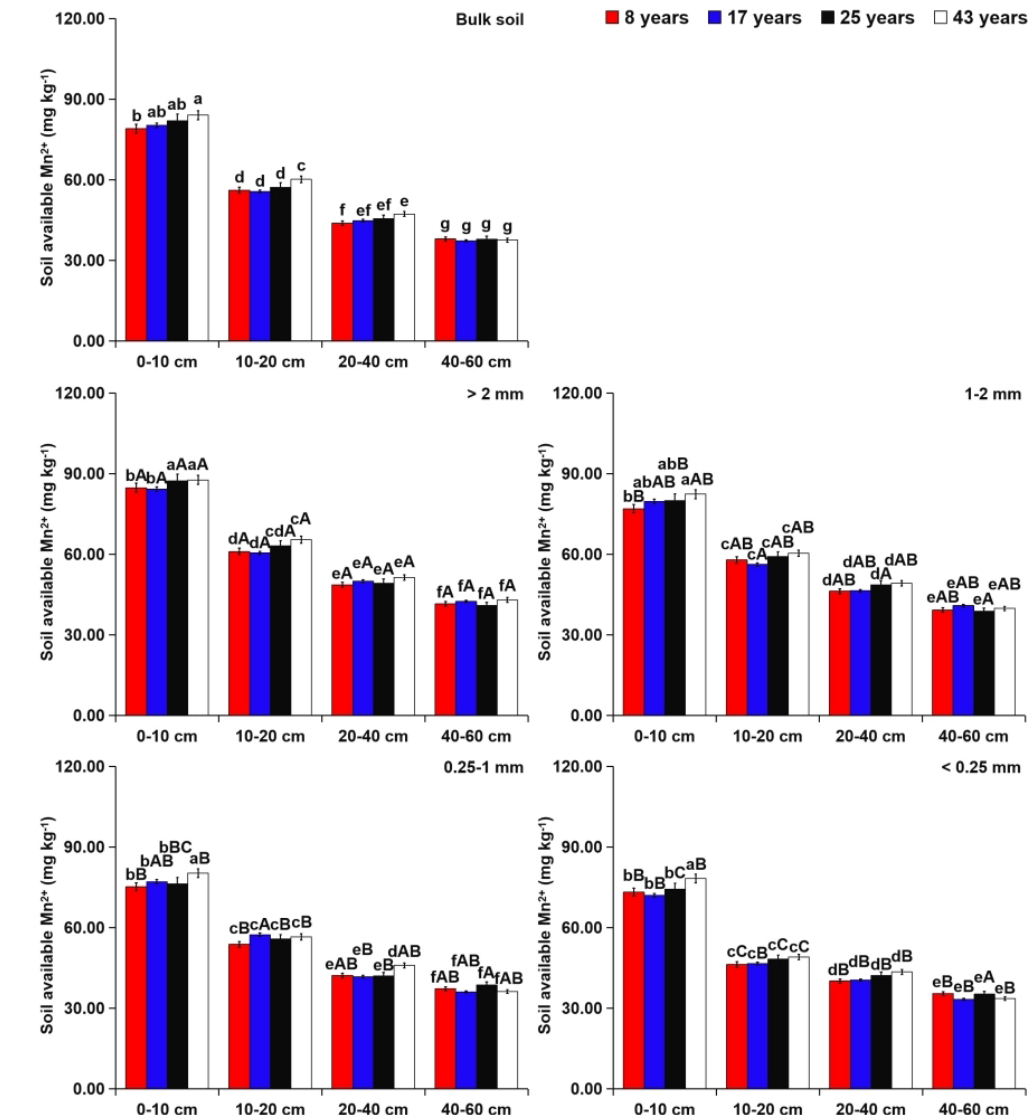
Figure 8. Effects of soil depth and tea plantation age on the available Mn 2 + content in bulk soil and different-sized aggregates. Data represent the mean of five replicates, and error bars represent the standard deviations. Means with the same lowercase letter are not significantly different ( p > 0 . 05) among different soil depths and tea plantation ages. Means with the same capital letter are not significantly different ( p > 0 . 05) among different-sized